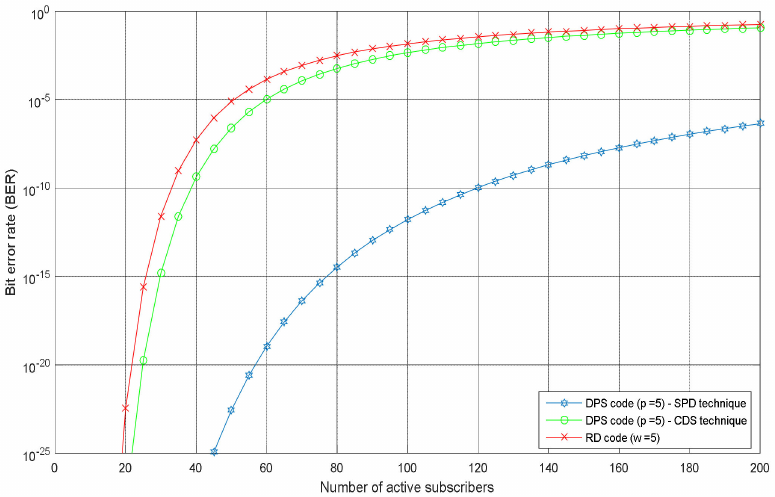
Figure 5. BER versus number of active users for DPS and RD codes at different detection techniques and different bit rates.